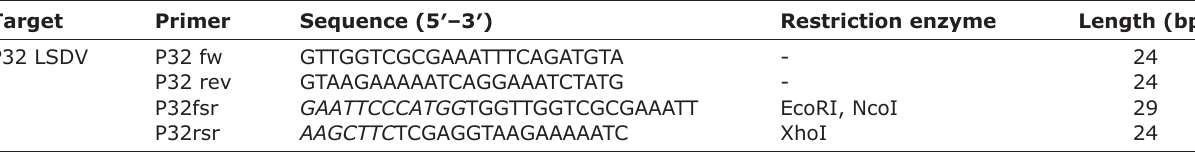
Table-1: Primers for amplification of gene P32 of LSDV.